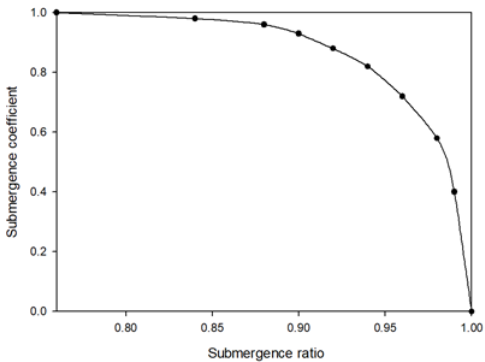
Figure 1. Relationship between the submergence coefficient and submergence ratio.